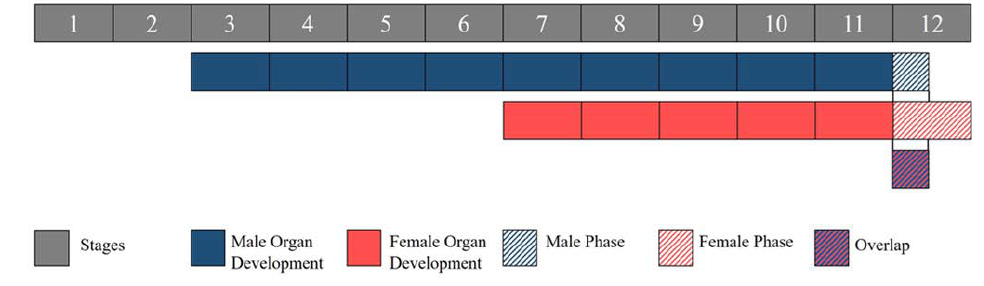
Fig. 10. Timing of reproductive organs maturity and sexual phase changes in incomplete proterandrous Malva